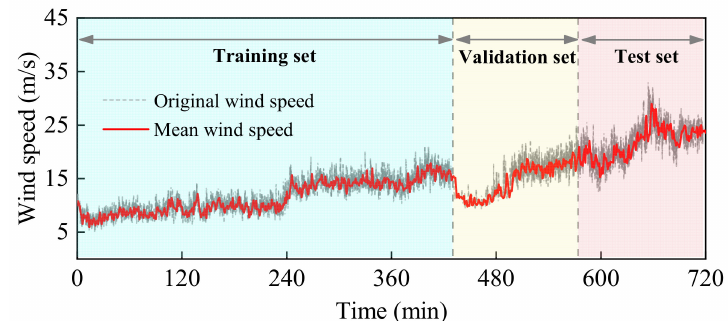
Figure 12. Mean wind speed of the tropical storm